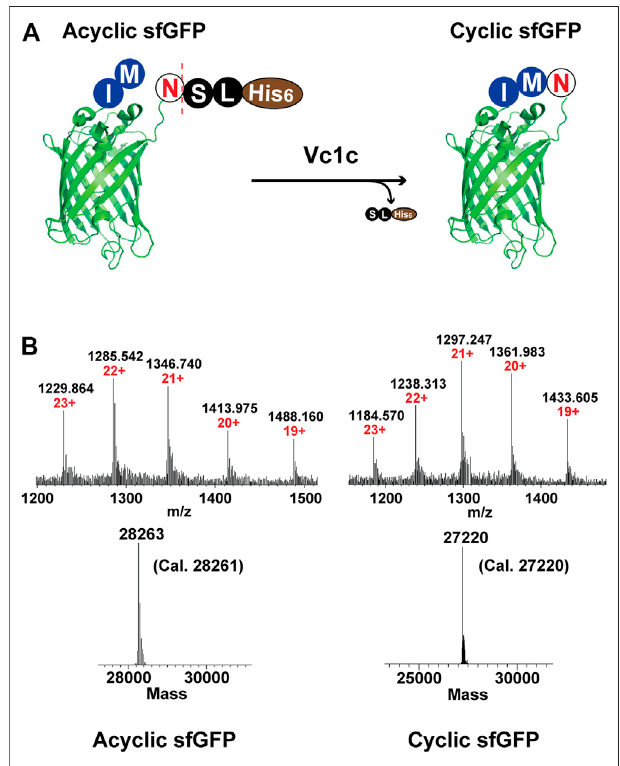
FIGURE 6 | Application of Vc1c in end-to-end cyclization of sfGFP. (A) Scheme of ligase-mediated sfGFP (generated from PDB code 2B3P) cyclization. sfGFP was co-expressed with an N-terminal Met-Ile and a C-terminal Asn-Ser-Leu-His6. The ligase can recognize and cleave the C-terminal motif Ser-Leu-His6 and perform end-to-end cyclization of sfGFP. (B) Upper: ESI-MS characterization of CM-sfGFP-NSL-His6 starting material or acyclic sfGFP (left) and cyclic sfGFP (right); Lower: Deconvolution of sfGFP cyclization(CM-sfGFP-NSL-His6:Cal.28261,Obs.28263;CyclicsfGFP:Cal. 27220, Obs. 27220). The cyclization reaction was performed at pH 7.0, 37 ° C for 30 min using 25 µM CM-sfGFP-NSL-His6 and 500 nM